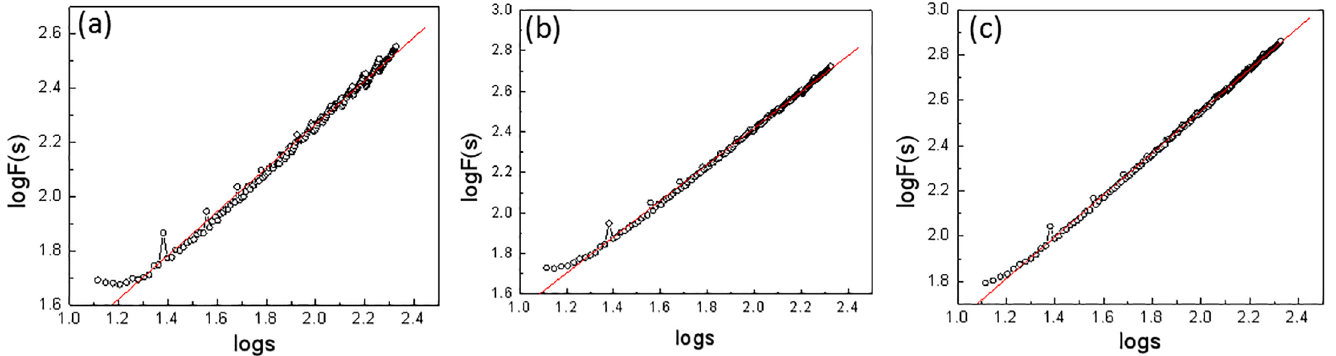
Fig 4. The scaling rate of the monthly mean temperatures during 1909–2014 at the three stations: (a) Harbin; (b) Changchun; (c) Shenyang.